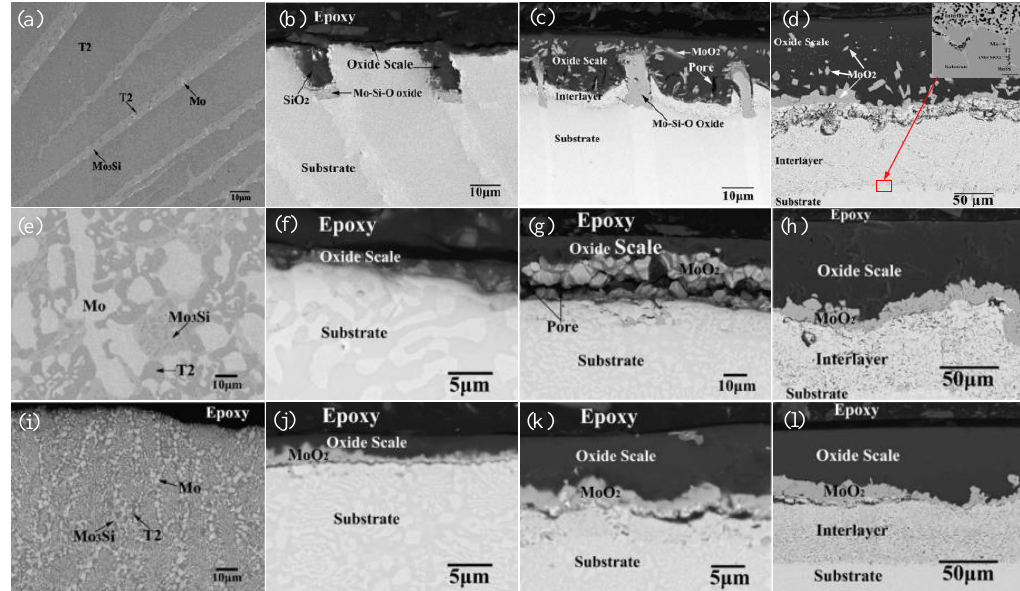
Figure 1. BSE micrographs of arc-melted Mo – 12.5Si – 25B ( a ), annealed ( e ) and laser-remelted Mo – 10Si – 14B ( i ) samples; Cross-sectional SEM images of the three samples oxidized at 1200 °C for different time: 10 min ( b , f , j ), 2 h ( c , g , k ) and 100 h ( d , h , l ). ( a – d ) and ( e – l ) reproduced with permission [38] and [41], respectively. Copyright 2007 Elsevier.